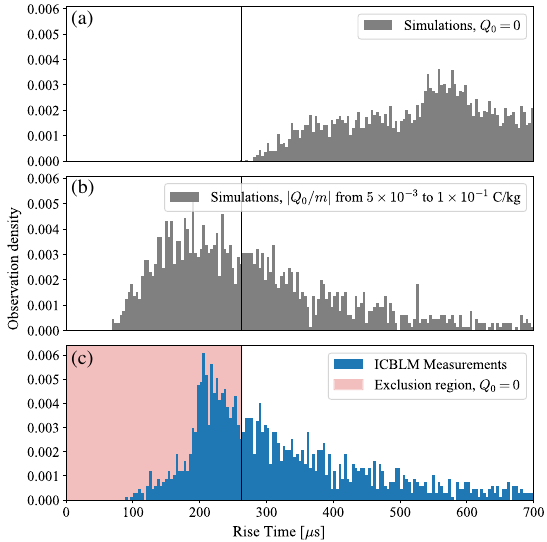
FIG. 6. Distribution of rise times R t found in Monte-Carlo simulations for initially neutral UFOs (a), for initially negatively charged UFOs (b) and found in ICBLM measurements for colliding beams at top energy